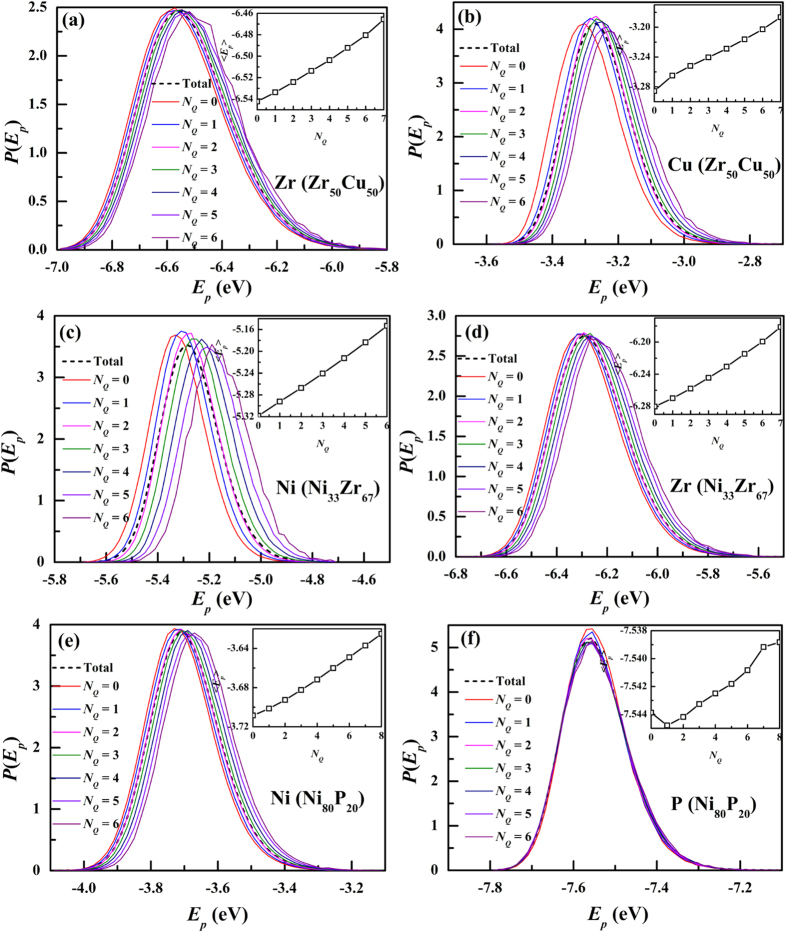
The distribution of potential energy for (a) Zr and (b) Cu in Zr50Cu50, (c) Ni and (d) Zr in Ni33Zr67 as well as (e) Ni and (f) P in Ni80P20 with different NQ at Tg + 150 K. Insets are the NQ dependence of the average per-atom potential energy.